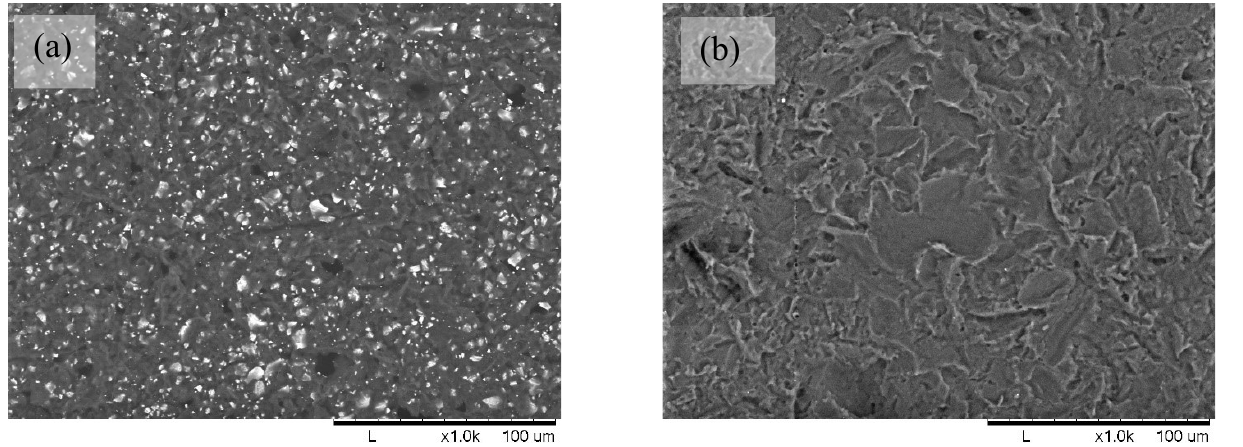
Figure 4. SEM image of solvent casted films: ( a ) POM/PLA film; ( b ) blank PLA film at 1000x magnification.